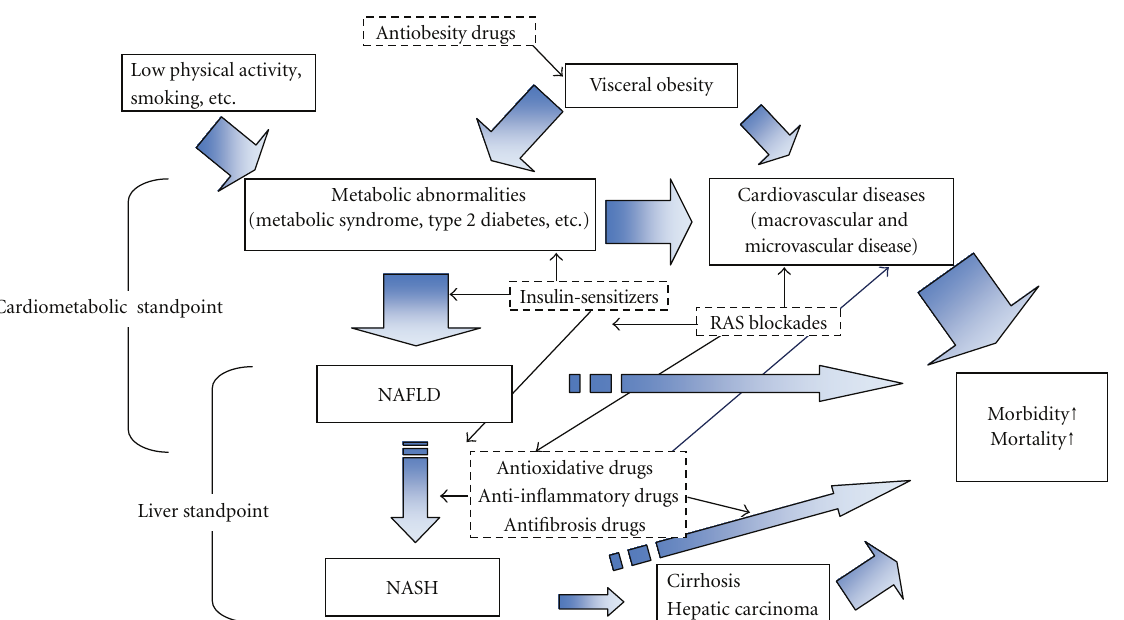
Figure 1: Therapeutic options and their main e ff ects on NAFLD and